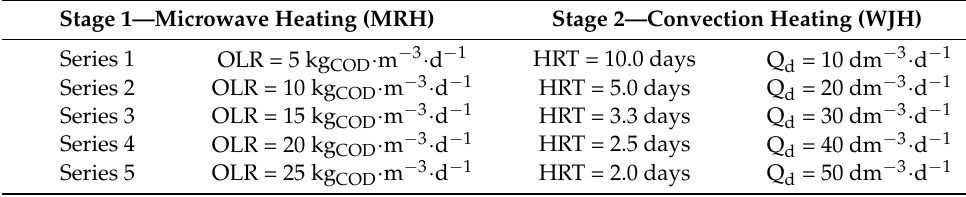
Table 1. Study design.